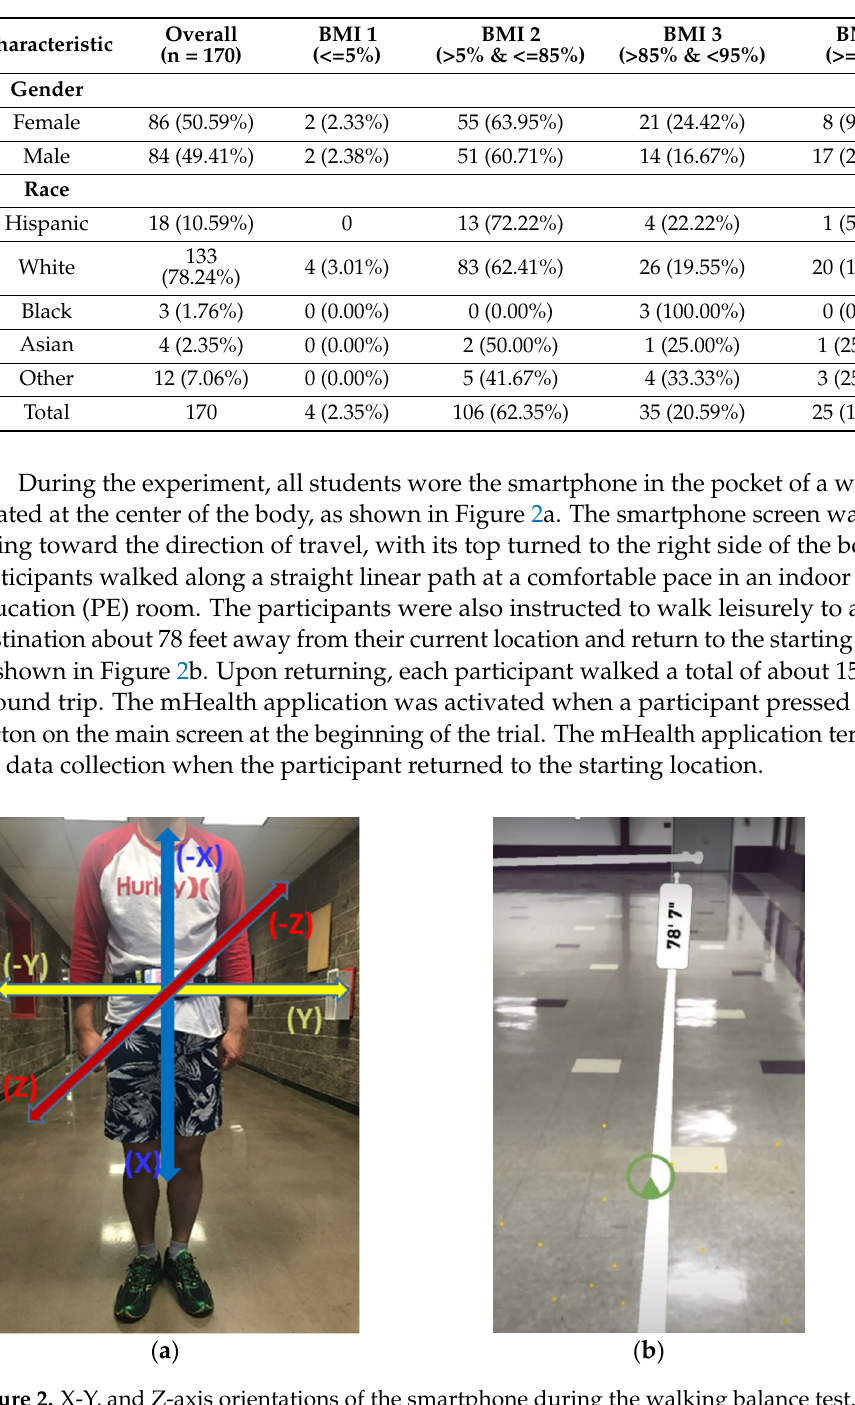
Table 2. Demographic information of the student participants.